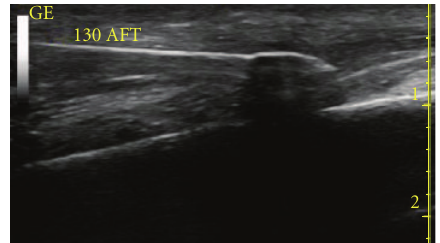
Figure 6: Cryolesion is barely visible at 1 minute and 30 seconds into the thaw